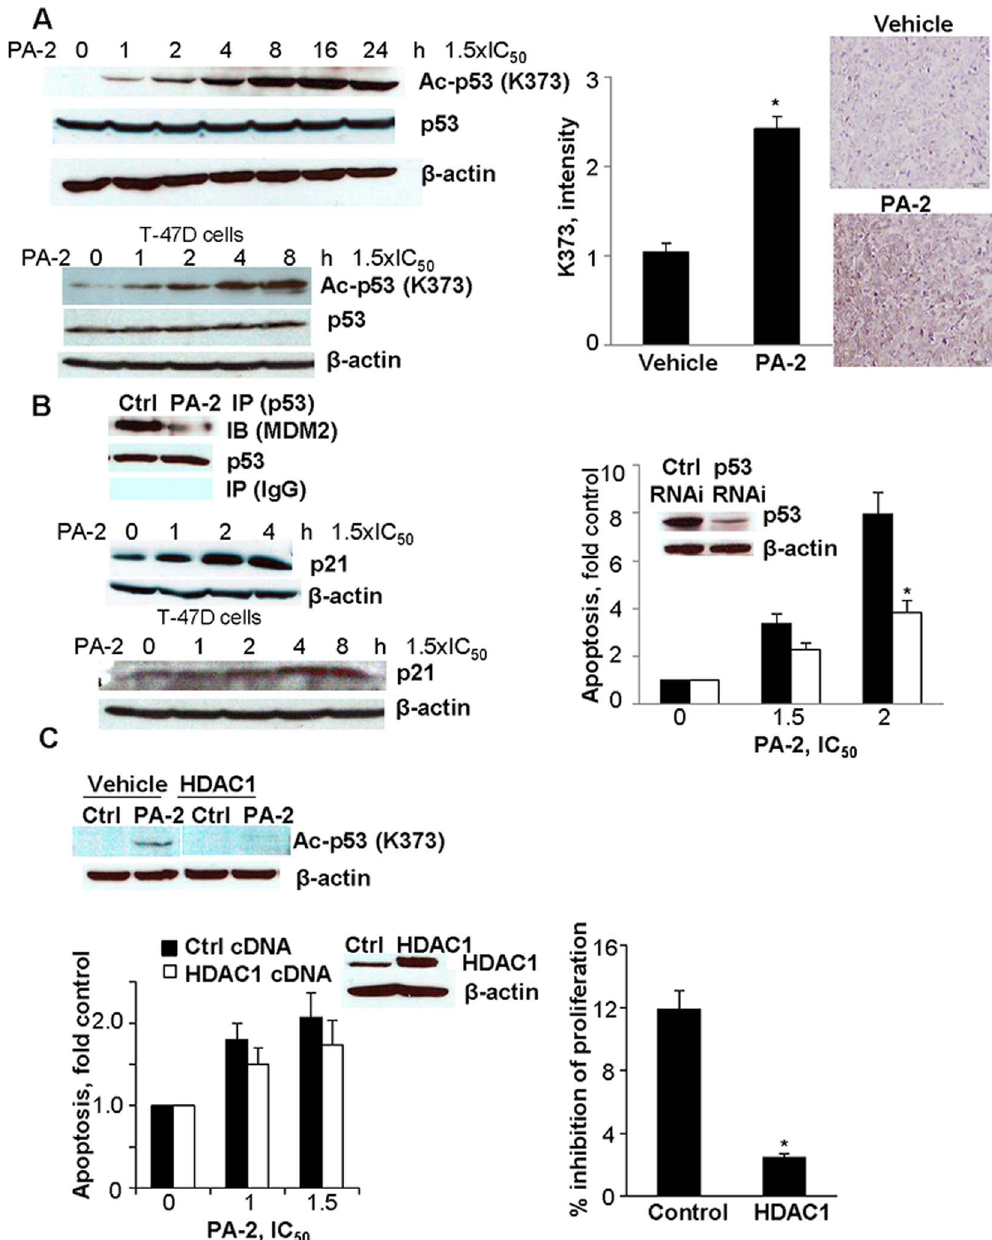
Figure 4. Phospho-aspirin-2 acetylates p53. A: Left : PA-2 induced the acetylation of p53 in MCF7 or T-47D cells (K373) in a time-dependent manner. Right : PA-2 induced p53 acetylation in MCF7 xenograft (K373). Representative images (right) and the quantification (left) of acetylated p53 (K373) positive cells in tumor sections, * p , 0.001. B: Left : The effect of PA-2 on p53-MDM2 interaction as determined by immuno-precipitation (top) and the expression of p21 by western blot (bottom). Right : siRNA-mediated knockdown of p53 attenuated the pro-apoptotic effect of PA-2 in MCF7 cells (results are the average of three independent experiments, *p , 0.05). Knockdown of p53 was determined by western blot. C: HDAC1 overexpression suppressed the anticancer activity of PA-2. Left : HDAC1 overexpression abrogated PA-2-induced the acetylation of p53 at K373 (top) and mildly suppressed its ability to induce apoptosis in MCF7 cells (bottom, results are the average of three independent experiments, *p , 0.05). Right : HDAC1 overexpression suppressed the effect of PA-2 on cell proliferation in MCF7 cells (results are the average of three independent experiments, *p , 0.05).